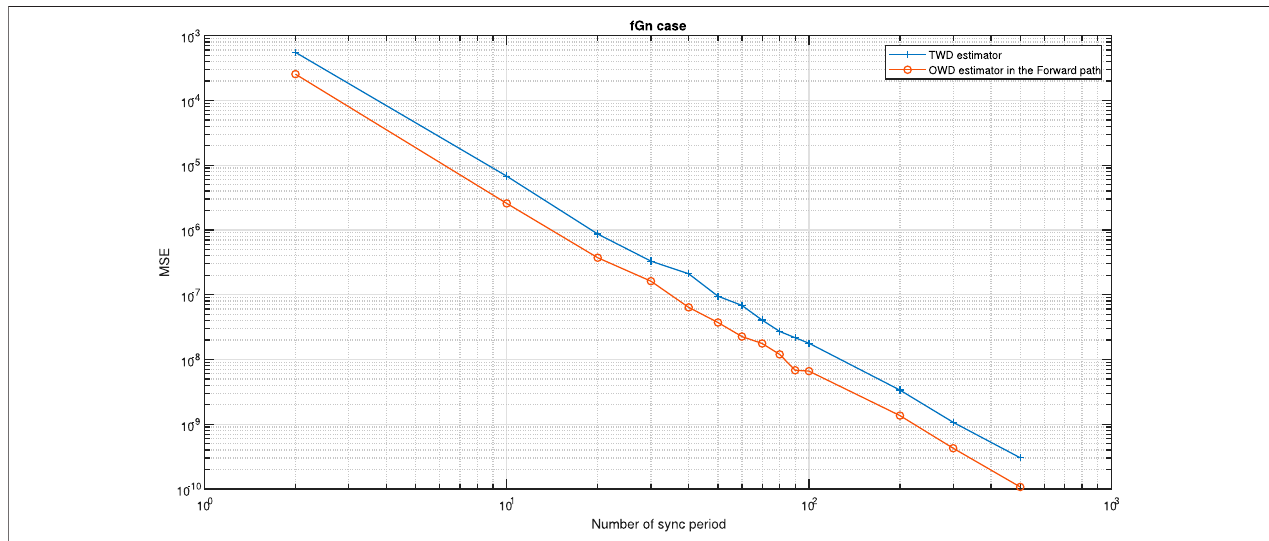
FIGURE 2 | Test case a of Theorem 8. Performance (MSE) comparison between the OWD clock skew estimator in the Forward path ( Eq. 61 ) and the TWD clock skew estimator ( Eq. 60 ). The PDV is an fGn process. α = 50 ppm , Q = 5 ms , T syn (cid:2) 15 . 6 ms ( 64 packet